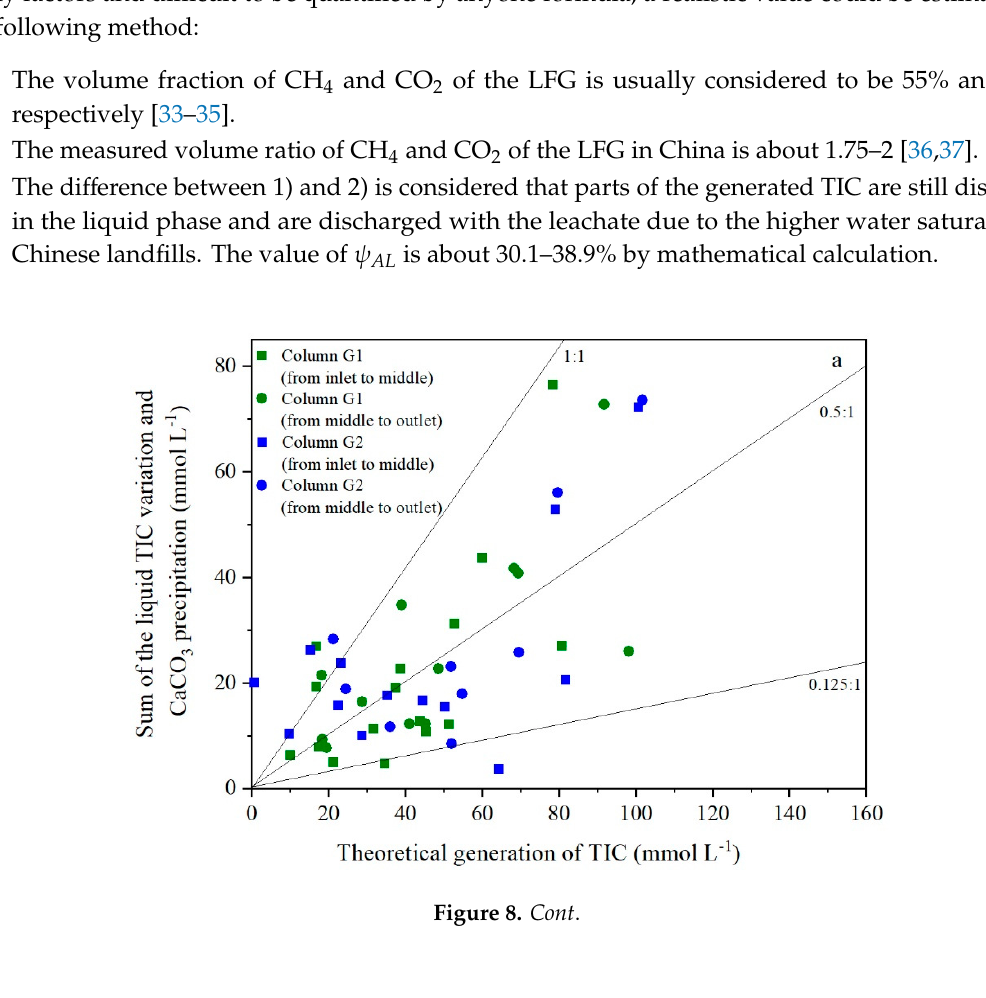
Figure 8. Total inorganic carbon (TIC) retention ratio: ( a ) group G and ( b ) group N. 3.3.2. pH value Changes Because the acidity of carbonate is significantly lower than that of acetic acid, propionic acid, and butyric acid, the pH value of the leachate gradually rose with the VFAs degradation. When the pH value changed from 6.5 to 7.5, the ionized CO 32 − ratio increased by an order of magnitude, which further caused an important impact on the biochemical clogging reactions. In this study, the maximum pH value variation was measured about 1.3 from the outlet to inlet, and a significant negative correlation between the changes of pH value and total VFAs concentrations was observed (Figure 9). According to the column experiment results, a calculation formula was proposed to reflect this relationship: